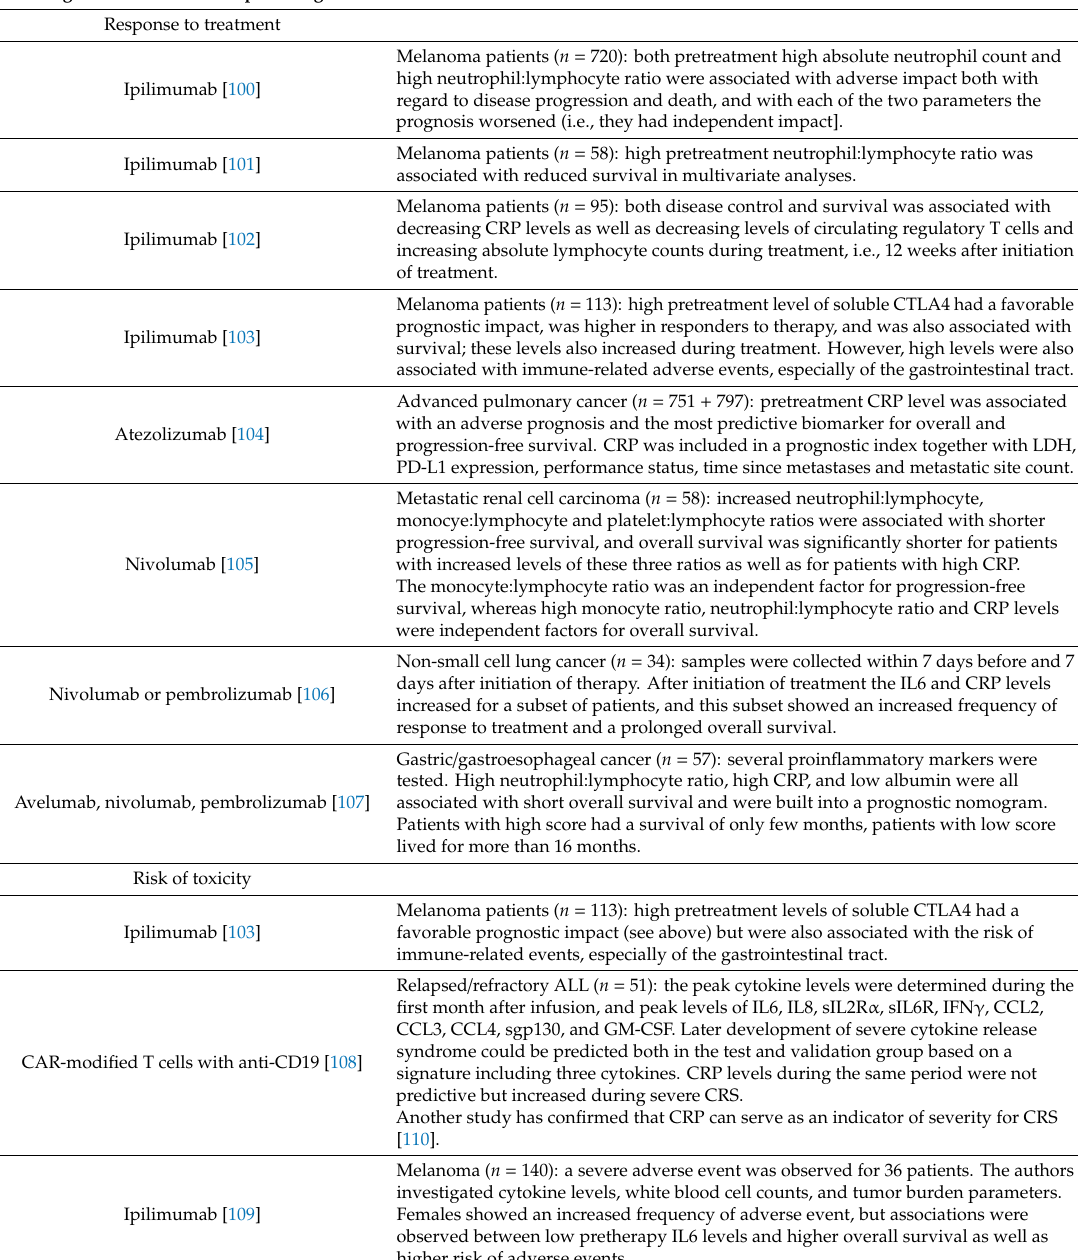
Table 5. The use of proinflammatory markers for prognostication in patients receiving anticancer immunotherapy; a summary of the results from important large clinical studies [99–109] 1